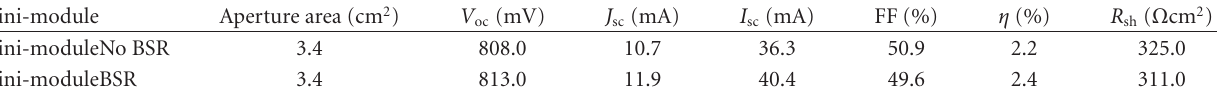
Table 4: J - V results from the two mini-modules with and without the application of a white paint BSR.